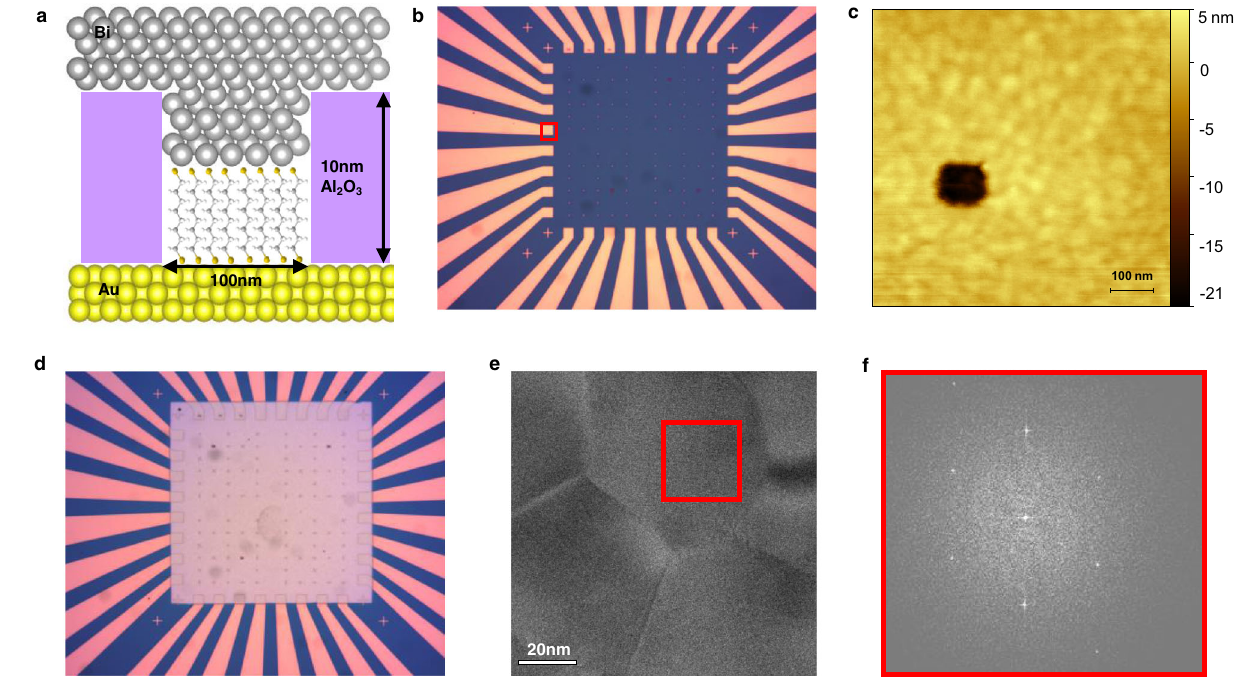
Fig. 2 | Structure and fabricationof the MEJs. The fabrication scheme isoutlined in Methods. a Schematic presentation of a junction with its (not drawn to scale) dimensions. b Anopticalimageofadevicecontaining31junctions.TheAufeatures arecoveredbyanAl 2 O 3 layerandaporeisformedattheendofeachAulead(within anarea suchasthe one markedby the red rectangle). c An AFM image of one pore